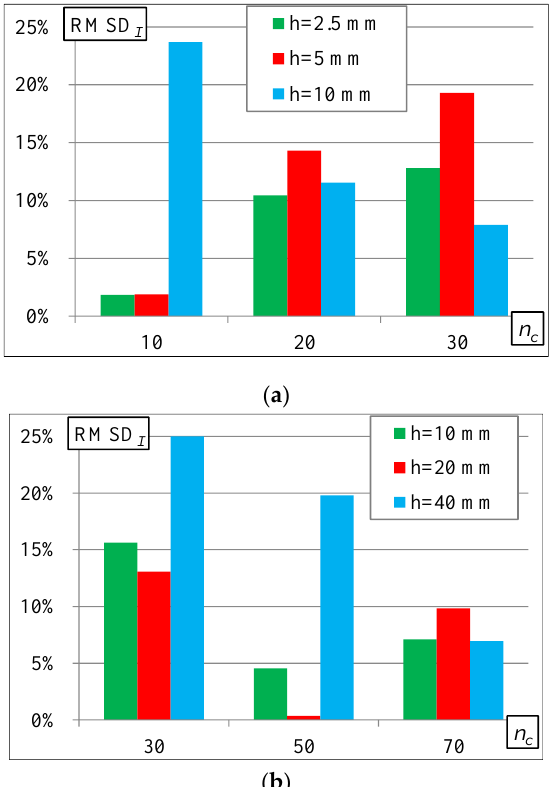
Figure 12. Root-mean-square deviation of the coils currents for considered frequency bandwidth and different WPT cell geometry: ( a ) r c = 5 mm and ( b ) r c = 20 mm.